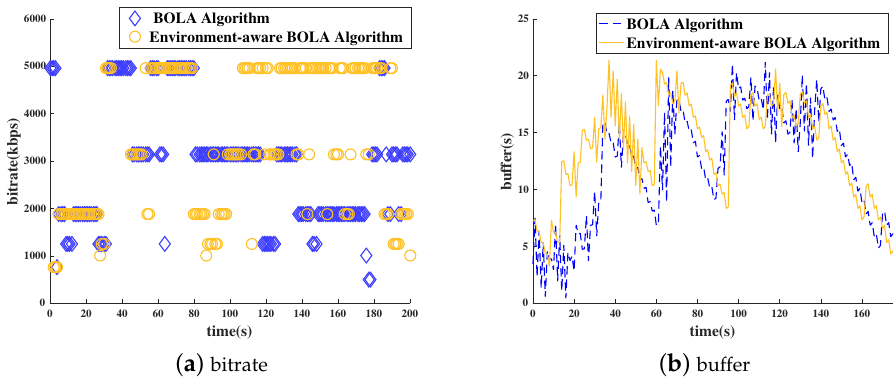
Figure 5. Bitrate and buffer (quiet and static environment): ( a ) bitrate, ( b ) buffer